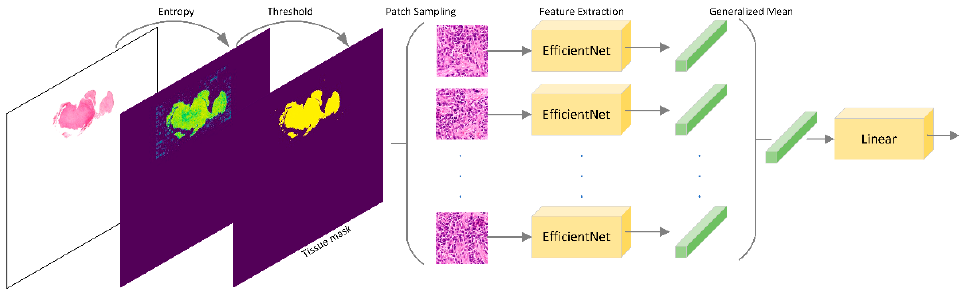
Figure 4. Overall architecture of the model developed by team